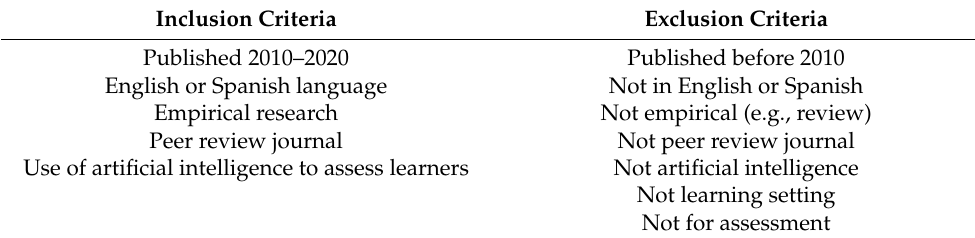
Table 1. Inclusion and exclusion